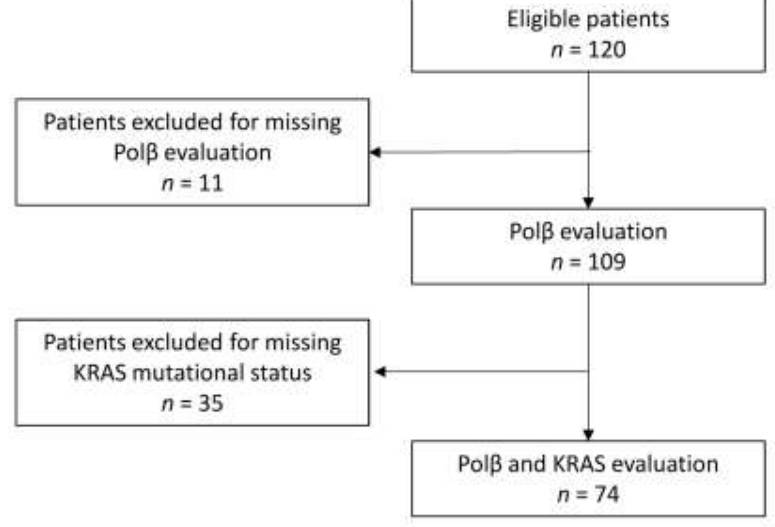
Figure 1. CONSORT diagram showing the flow of participants.